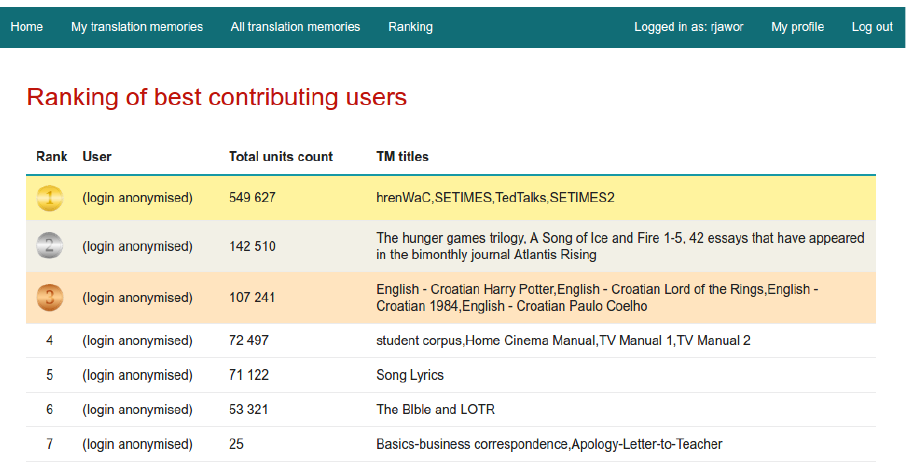
Figure 2. List of the best contributors.